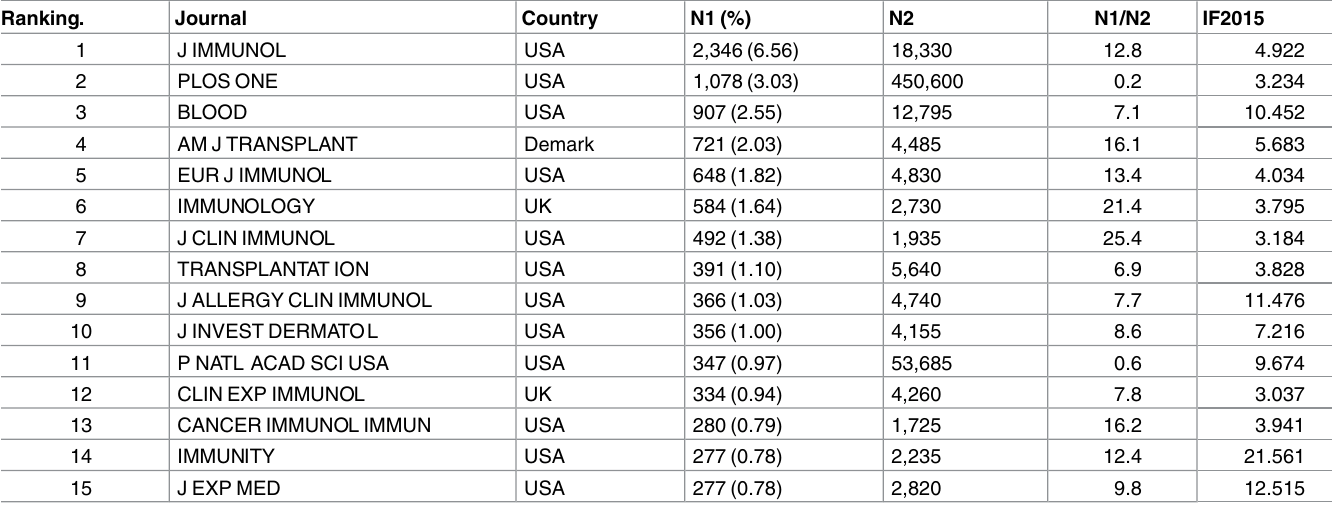
Table 2. The top active15 journalsthatpublishedarticles on regulatory T cell (Treg) research from 2000 to 2015.